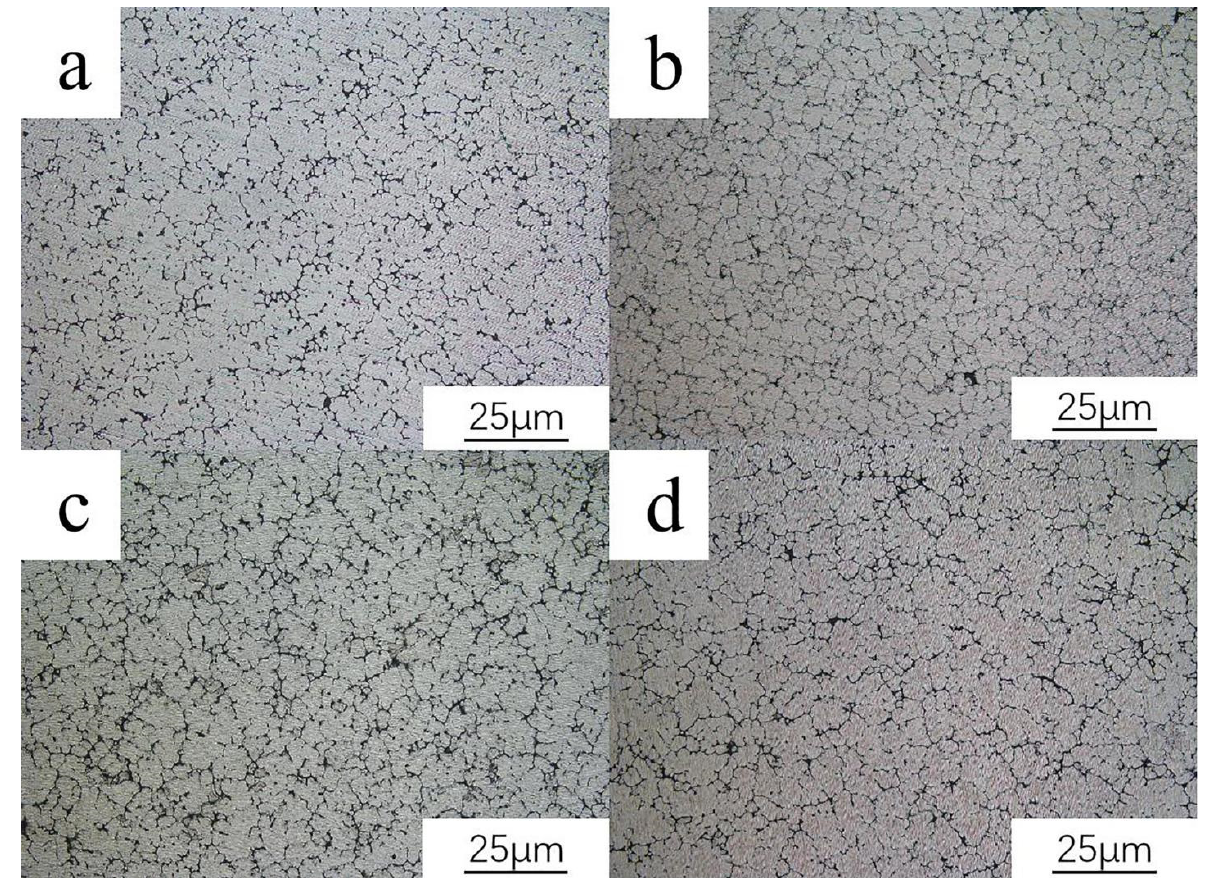
Figure 1. Microstructure of Al-5Mg-3Zn-1Cu alloy with different Ce content: ( a ) 0.0 Ce wt.%, ( b ) 0.15 Ce wt.%, ( c ) 0.25 Ce wt.%, ( d ) 0.50 Ce wt.%.